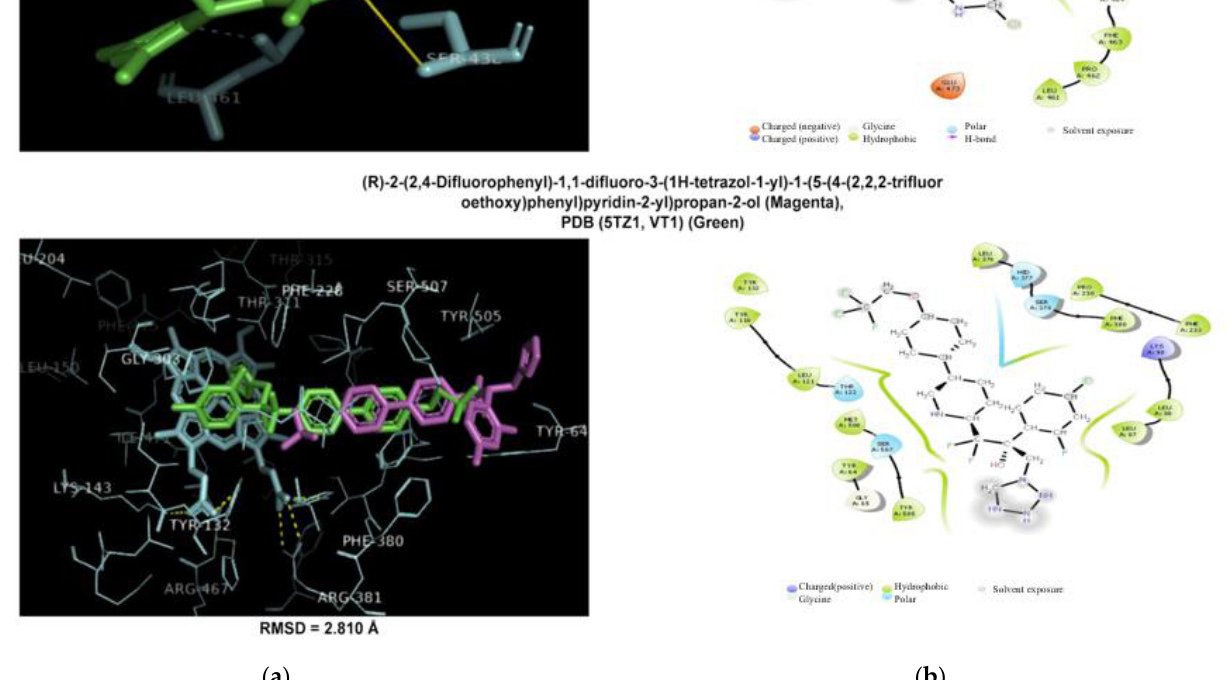
Figure 7. The binding states ( A ) is showing hydrogen bonds residues coloredin cyan and 2D interaction diagrams ( B ) for the compounds 4 , 5 and the candidate VT-1161 based on the native ligand (VT1) in co-crystalized state ligand (green) and docked state (magenta) against sterol 14-α-demethylase (CYP51) from Candida albicans , obtained from the PDB structure (5TZ1).